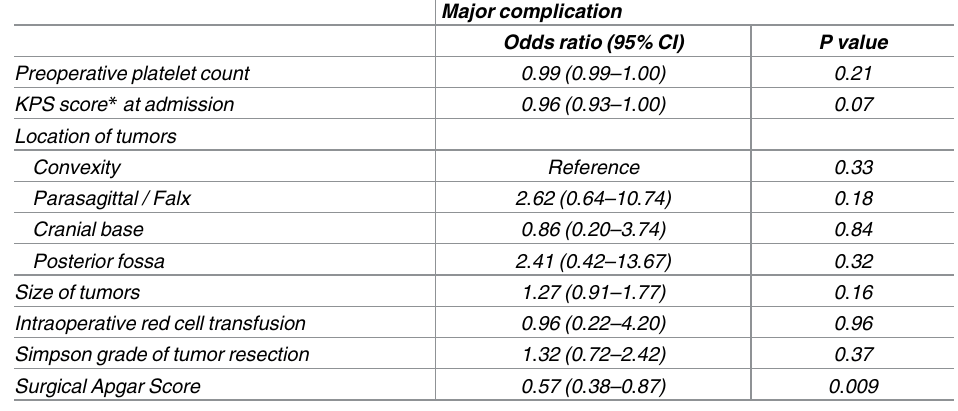
Table 4. Multivariable analysis for independent predictors of major complications after intracranial meningioma